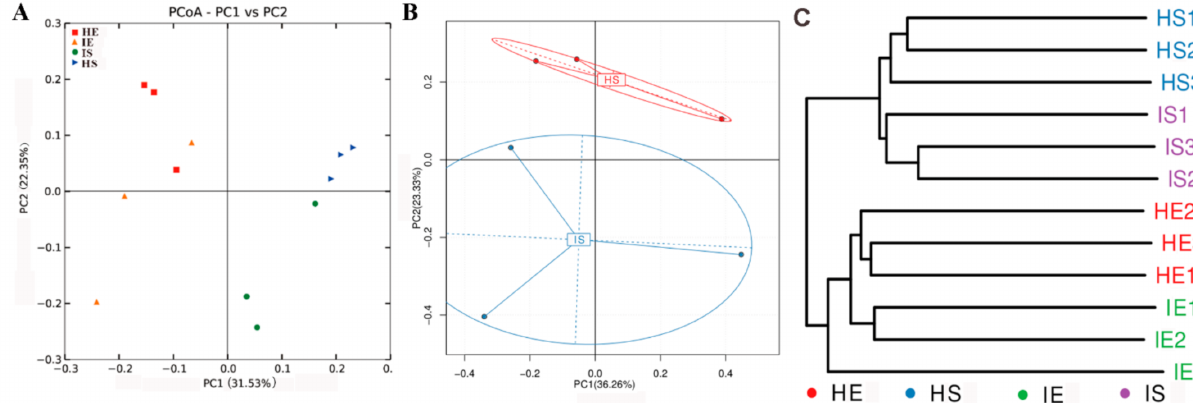
Figure 2. Comparison of the rhizosphere and endophytic community structures based on pyrosequencing of 16S rDNA amplicons and metagenomics. ( A ) Principal coordinates analysis (PCoA) based on 16S OTU abundance. Number in brackets represents contributions of principal components to differences among samples. A dot represents each sample, and different colors represent different groups (red: HE; blue: HS; orange: IE; green: IS). ( B ) Principal component analysis (PCA) based on gene abundance. Number in brackets represents contributions of principal components to differences among samples. A dot represents each sample, and different colors represent different groups (red: HS; blue: IS). ( C ) Unweighted pair group method with arithmetic mean (UPGMA) analysis based on 16S OTU abundance (HS: rhizosphere in healthy samples; HE: endophytes in healthy samples; IS: rhizosphere in CLas-infected samples; IE: endophytes in CLas-infected